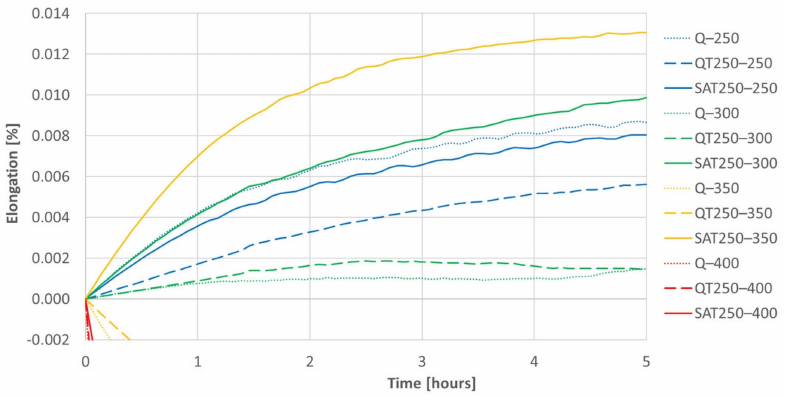
Figure 15. A detail of Figure 14 for positive elongation increments during isothermal tempering. The differences between samples processed with deformation and without are significant. These differences increasing with increasing temperature of the second tempering can be followed on the